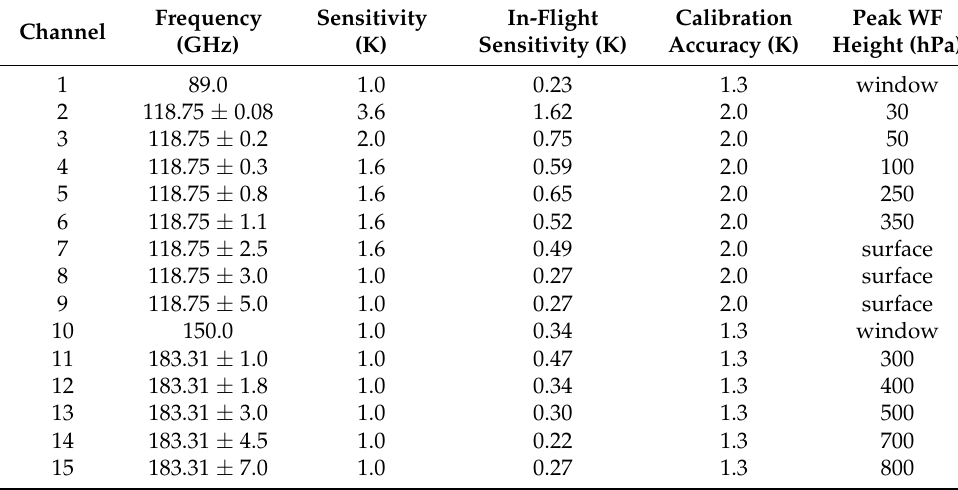
Table 1. Channel characteristics of